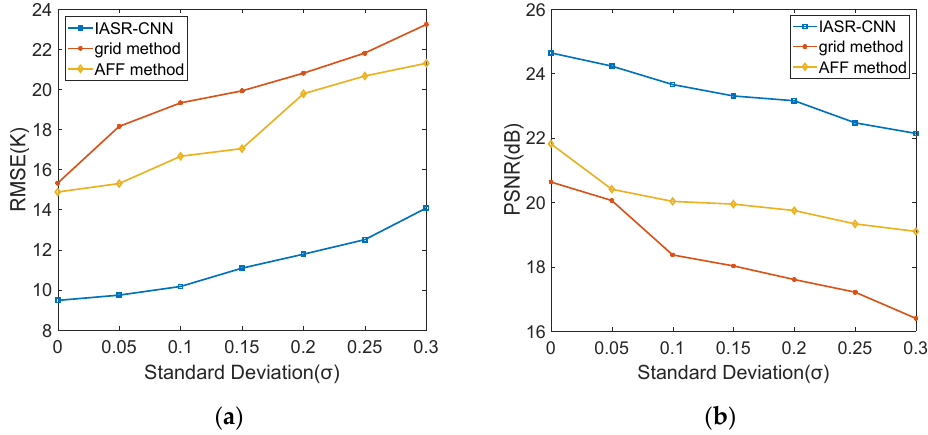
Figure 8. The evaluation metrics of the brightness temperature image reconstructed by different methods at variable noise intensities. ( a ) PSNR. ( b ) RMSE.